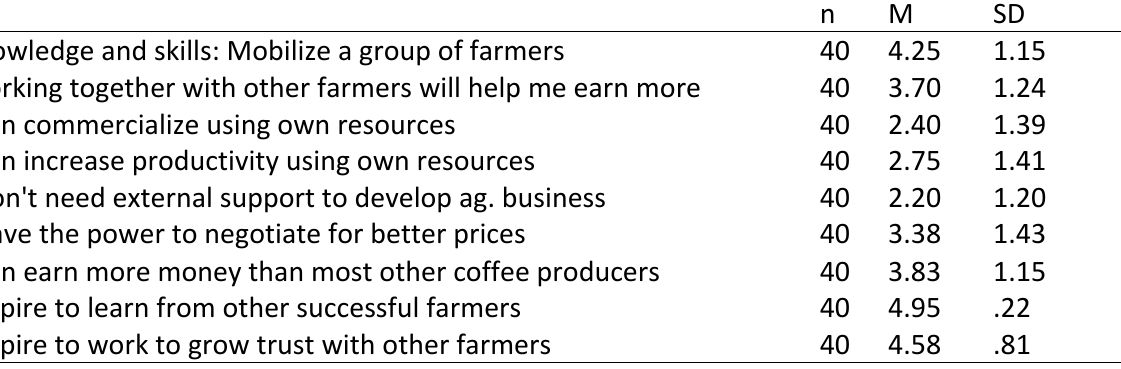
Farmers' Perceptions and Knowledge and Skills Central Tendency Measures